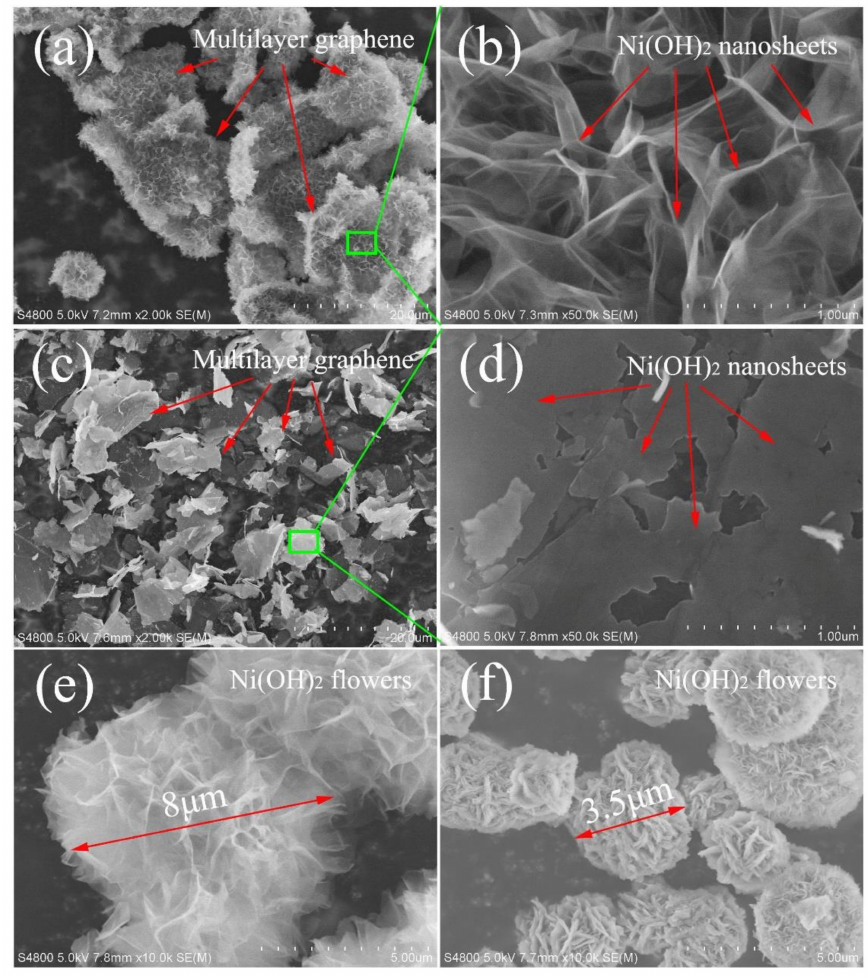
Figure 2. Scanning electron microscope (SEM) images of S-Ni(OH) 2 /MLG (( a ): low magnification ( b ): high magnification), L-Ni(OH) 2 /MLG (( c ): low magnification ( d ): high magnification), S-Ni(OH) 2 ( e ) and L-Ni(OH) 2 ( f